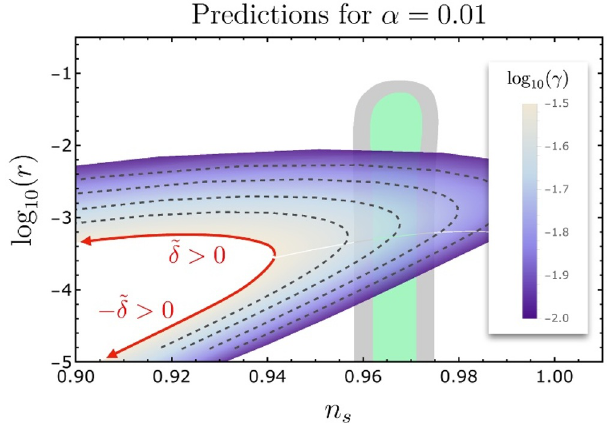
Figure 7 . We compare the Planck contours with the numerical predictions for n s and r computed through the Hubble slow-roll parameters, where we vary log log ( γ ) ∈ [ − 2 . 0 , − 1 . 5] , while fixing α = 0 . 01 . The black dotted lines correspond to fixed γ to 10 { 0 . 013 , 0 . 017 , 0 . 021 , 0 . 025 } , from right to left, respectively. The region ˜ δ > 0 corresponds to infla- tionary trajectories with wide initial condition range of the type shown in figure 6 ending up in the false minimum at φ 1 = 2 π/c 1 , φ 2 = −O (˜ δ ) .The complement ˜ δ < 0 corresponds to trajectories which in figure 6 start with φ 2 -values beyond the saddle point with little allowed initial condition space, and end up in the true minimum at φ 1 = φ 2 = 0